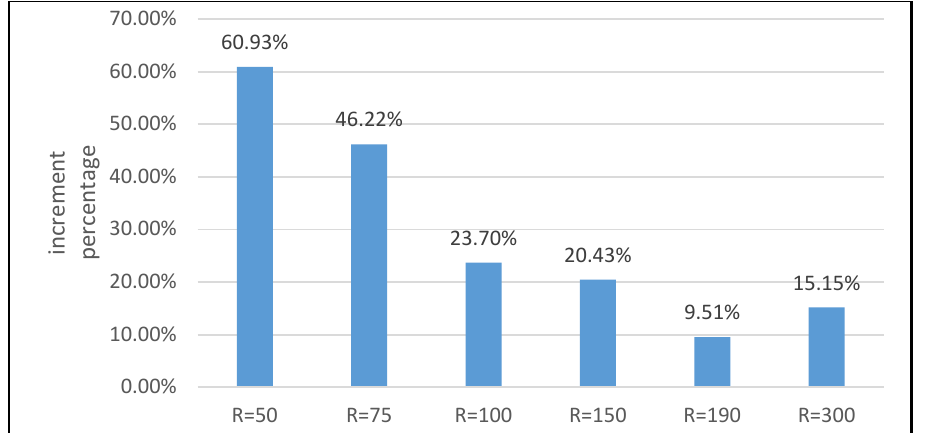
Fig. 9. Positive moment impact factors for different radii configurations.